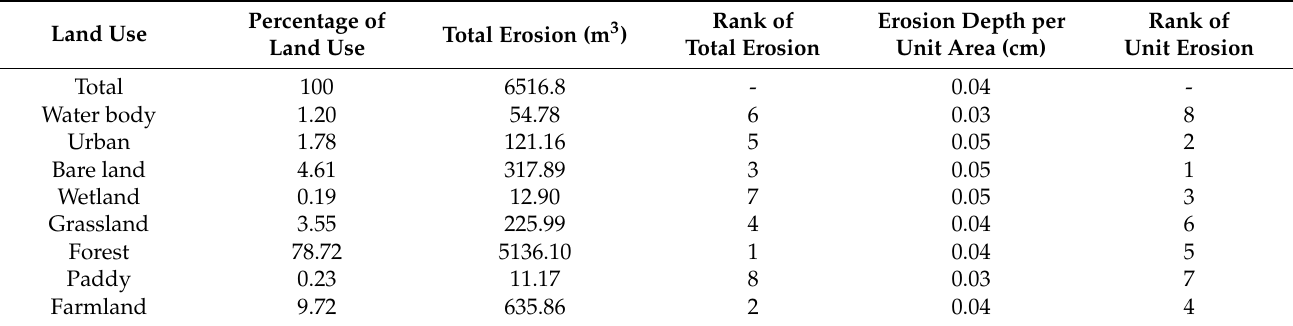
Table 3. Results of erosion by land use (R-SSEM).